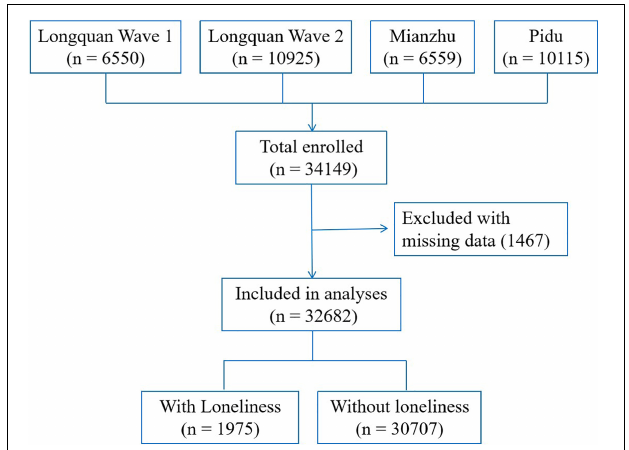
FIGURE 1 | The flowchart of participant